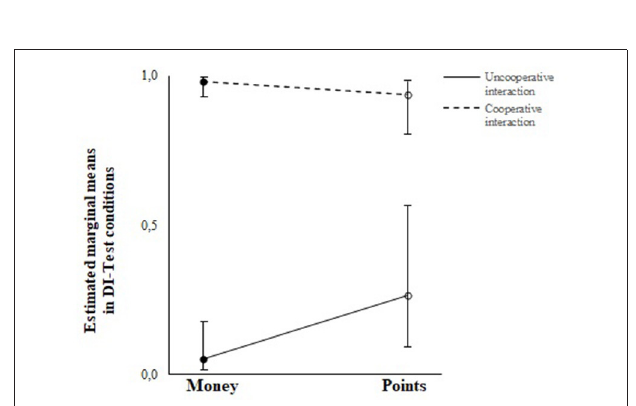
FIGURE 5 | Estimated marginal means of participant’s blue cards choices under disadvantageous inequity test conditions as a function of the information about monetary